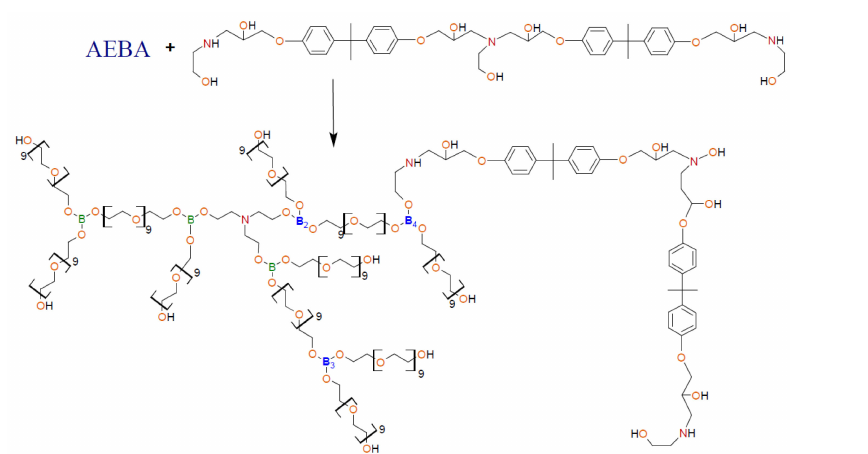
Figure 2. Scheme of EM synthesis.